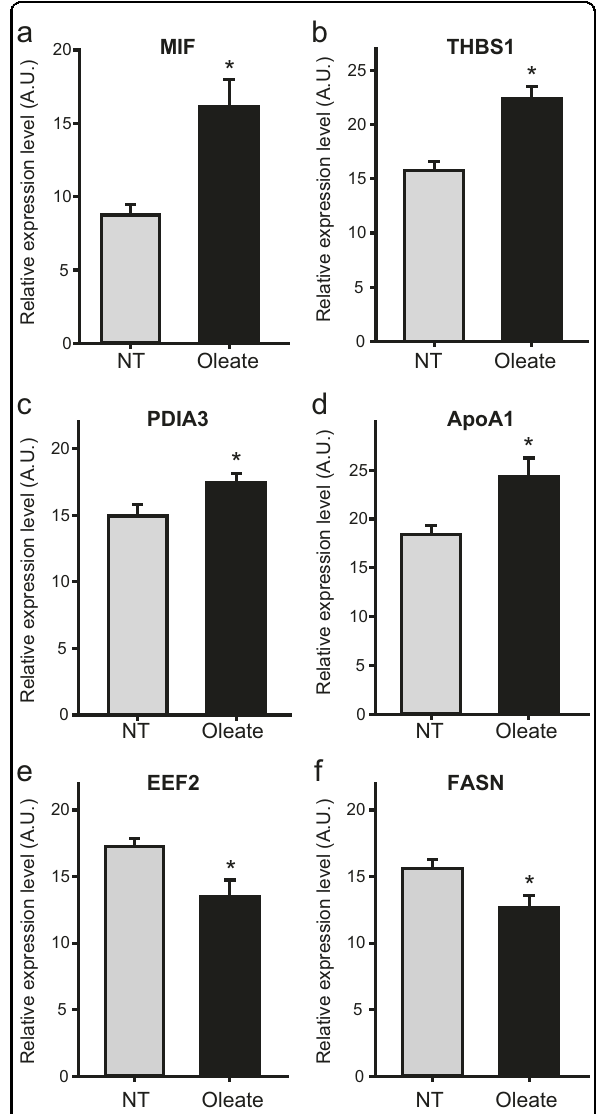
Fig. 4 Validation of upregulation and downregulation of the selected secreted proteins after oleate treatment. a – f Western blotting analysis of the six selected secreted proteins using an independent set of the conditioned media samples ( n ≥ 4): MIF ( a ), THBS1 ( b ), PDIA3 ( c ), APOA1 ( d ), EEF2 ( e ), and FASN ( f ). The results showed signi fi cant ( P < 0.05) upregulation of MIF, THBS1, PDIA3, and APOA1 and downregulation of EEF2 and FASN in oleate-treated samples compared to the untreated controls. The data are shown as the mean ± SEM. * P < 0.05 by Student ’ s t